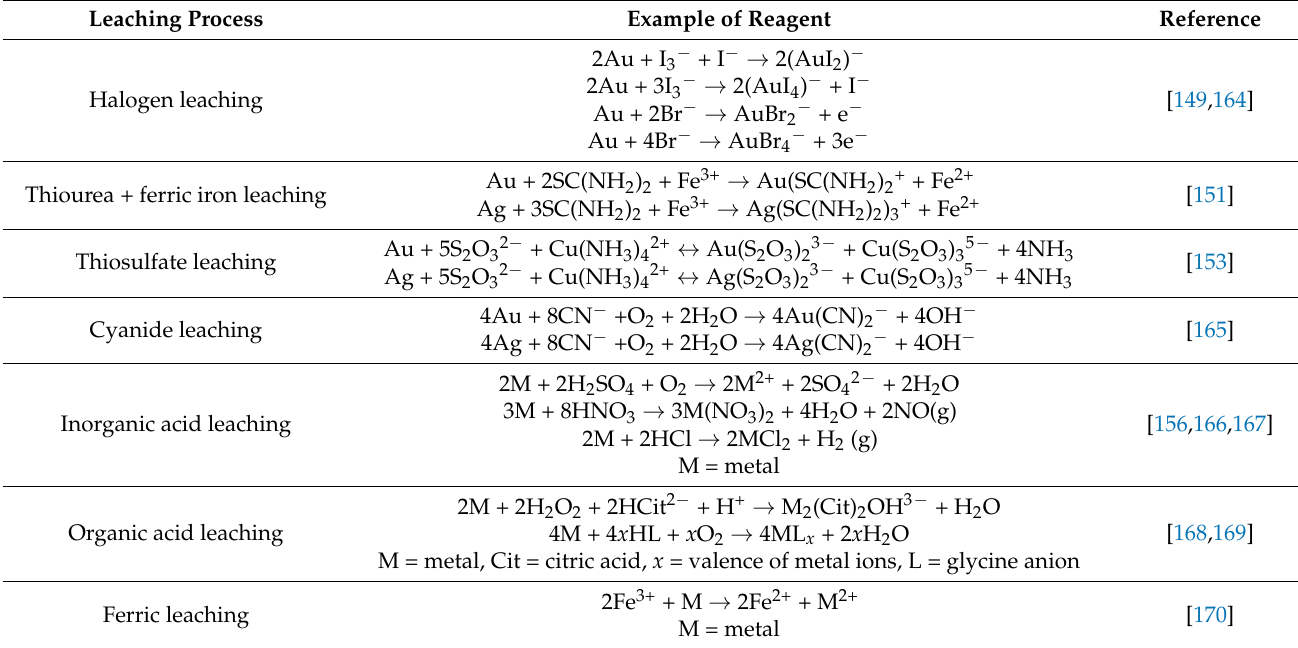
Table 4. Common metal solubilisation reactions that can be utilised for extracting metals from